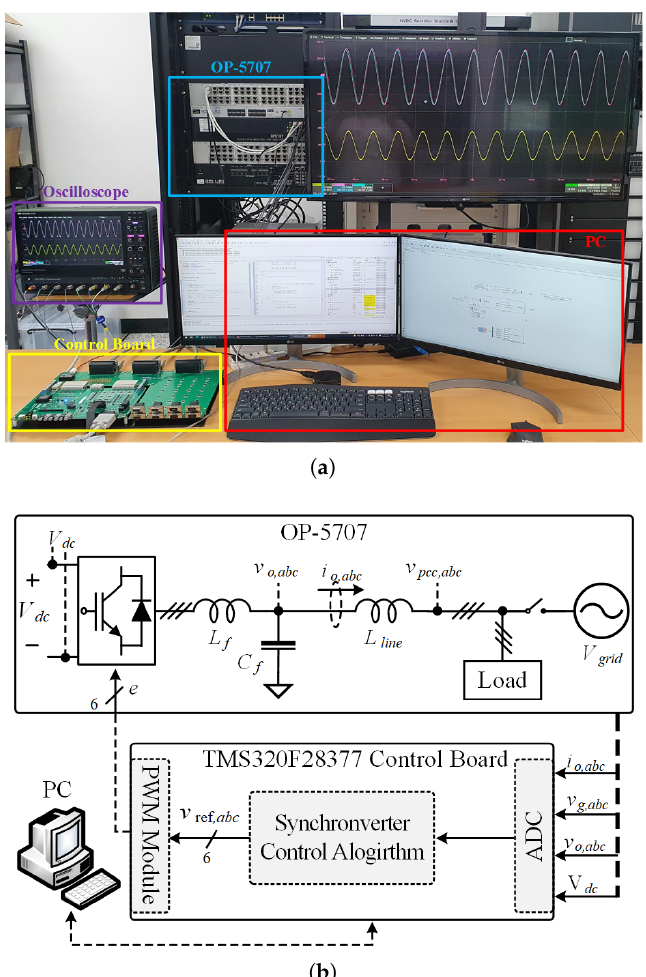
Figure 10. ( a ) Configuration of HILS based experimental setup, and ( b ) simplified HILS experiment block